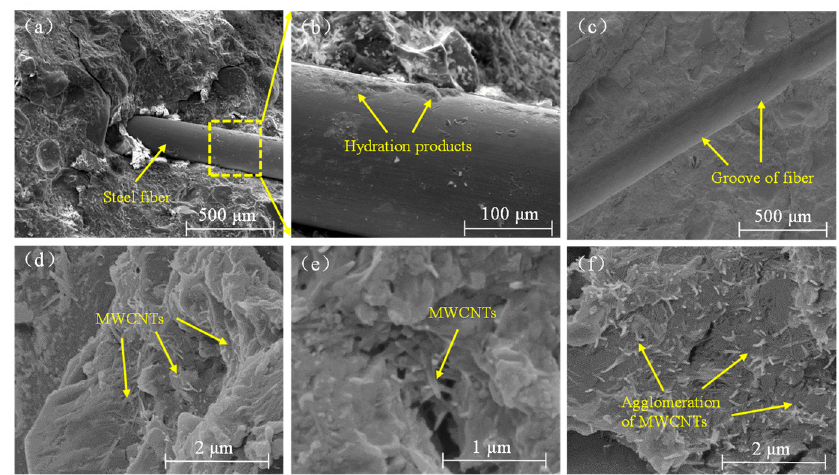
Figure 8. Scanning Electron Microscope analysis of steel fiber in the reactive powder concrete mortar ( a – c ), and multi-walled carbon nanotubes in the CF group ( d , e ) and CL group ( f